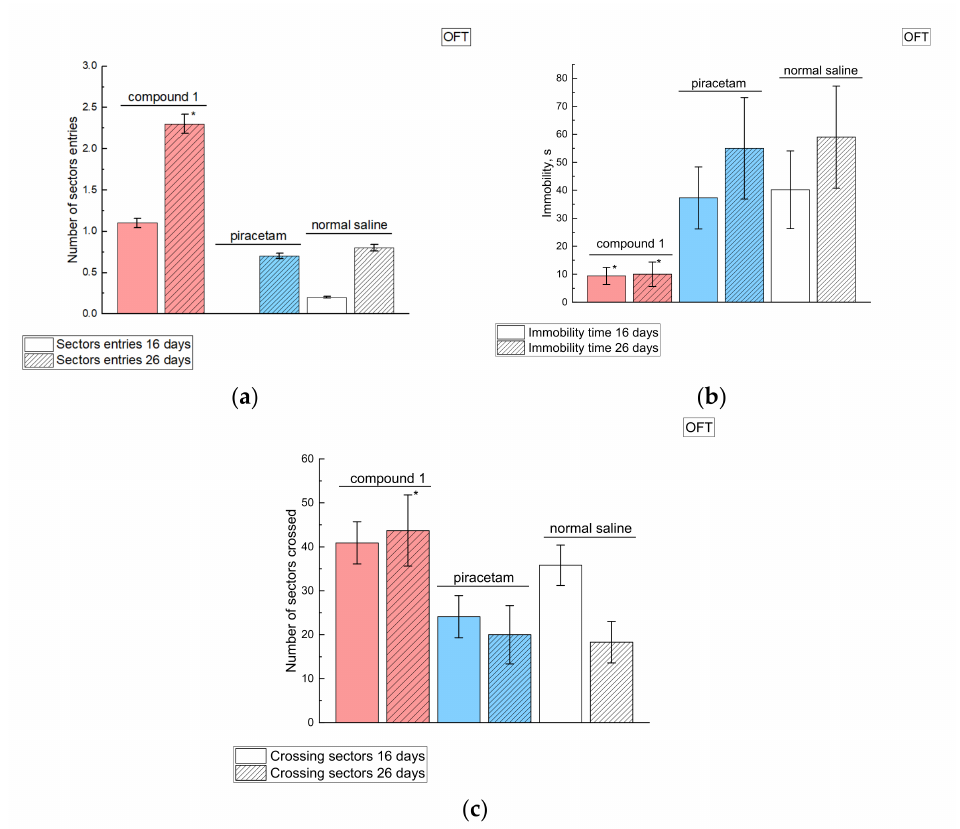
Figure 5. OFT test. ( a )—the average number of crossed central sectors; ( b )—immobility time; ( c )—the average number of sectors crossed. Empty rectangle—data for day 16; a rectangle with shading—data for 26 days. The results are expressed as the mean ± standard error (SE). * p <